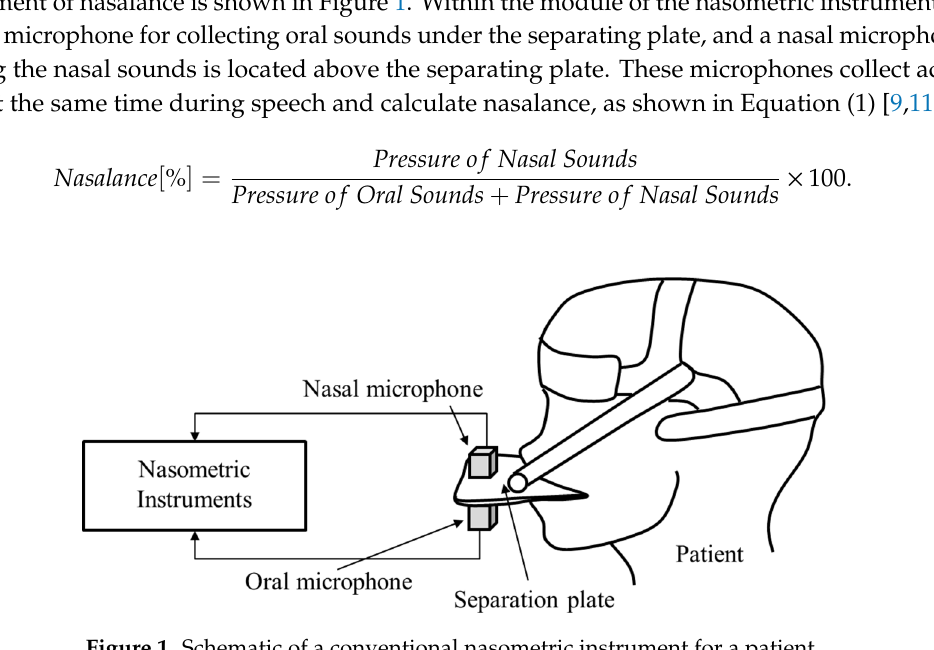
Figure 1. Schematic of a conventional nasometric instrument for a patient.